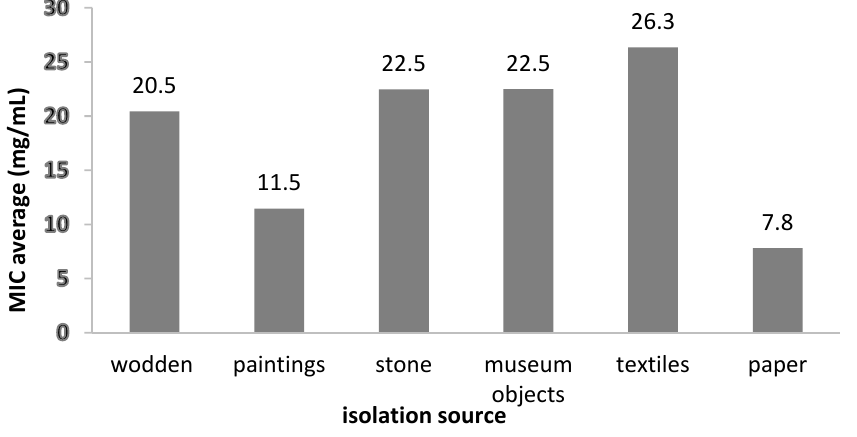
Figure 8. The average MIC values of the A. sativum extract on fungal strains, depending on the isolation sources.